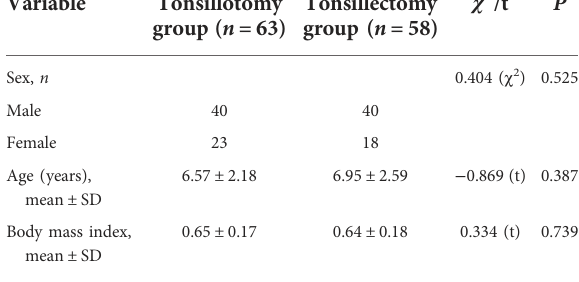
TABLE 1 Basic demographic information on the two patient